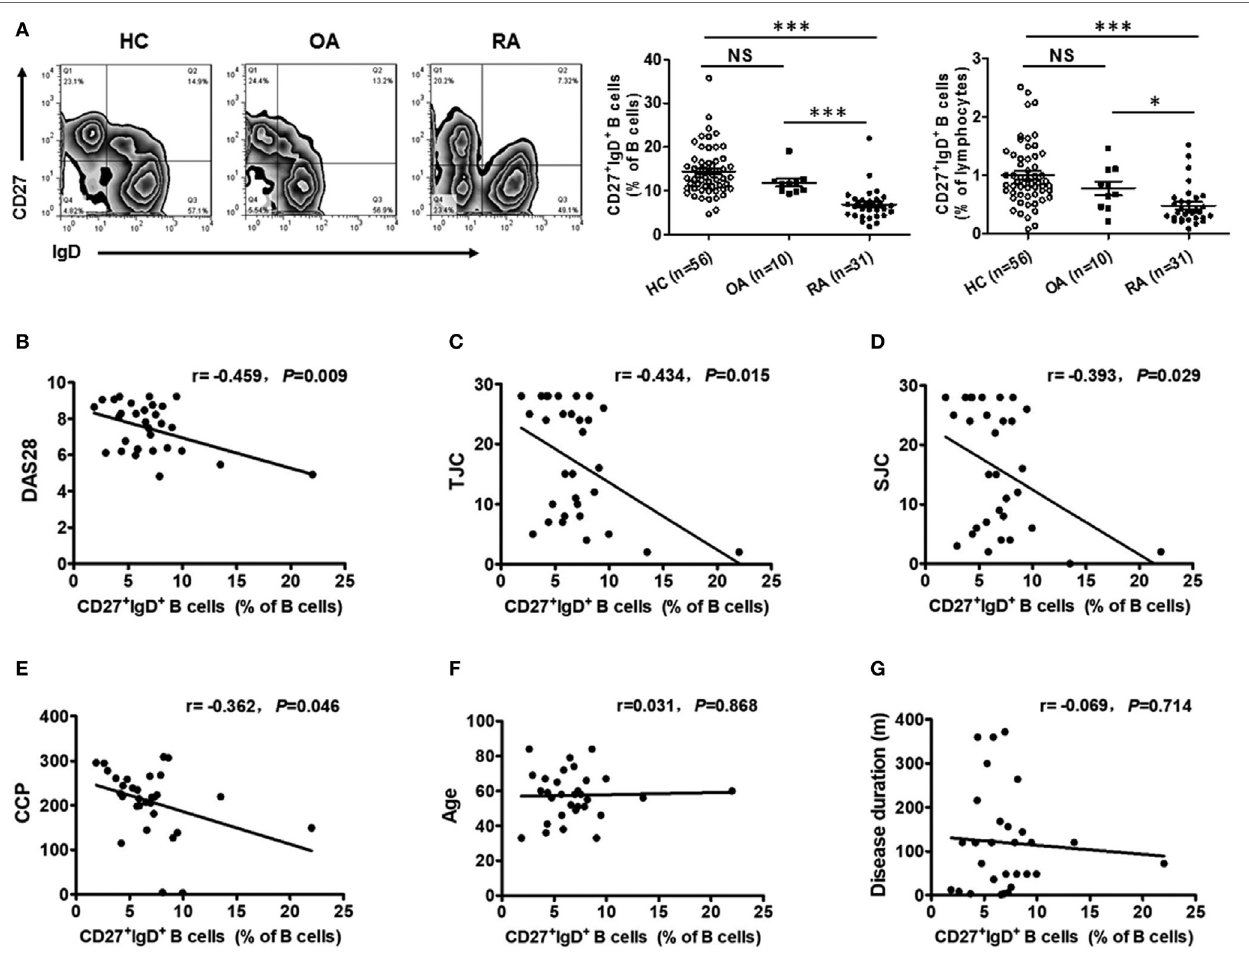
FigUre 2 | Decreased frequencies of CD27 + IgD + B cells in rheumatoid arthritis (RA). (a) Flow cytometric analysis of the frequencies of CD27 + IgD + B cells in the peripheral blood of 56 healthy donors, 31 RA patients as well as 10 non-autoimmune osteoarthritis patients. The representative flow charts and the statistical results (including CD27 + IgD + B cells% in B cells and CD27 + IgD + B cells% in lymphocytes) were shown (one-way ANOVA, * P < 0.05, *** P < 0.001, NS, not significant). And also, the correlation of CD27 + IgD + B cells with RA patient clinical manifestations, including the disease activity scores [DAS28, (B) ], the tender joint counts [TJC, (c) ], the swollen joint counts [SJC, (D) ], the anti-cyclic citrullinated protein antibodies [anti-CCP, (e) ], the age (F) , and the disease duration (g) was analyzed by the Spearman test (* P <